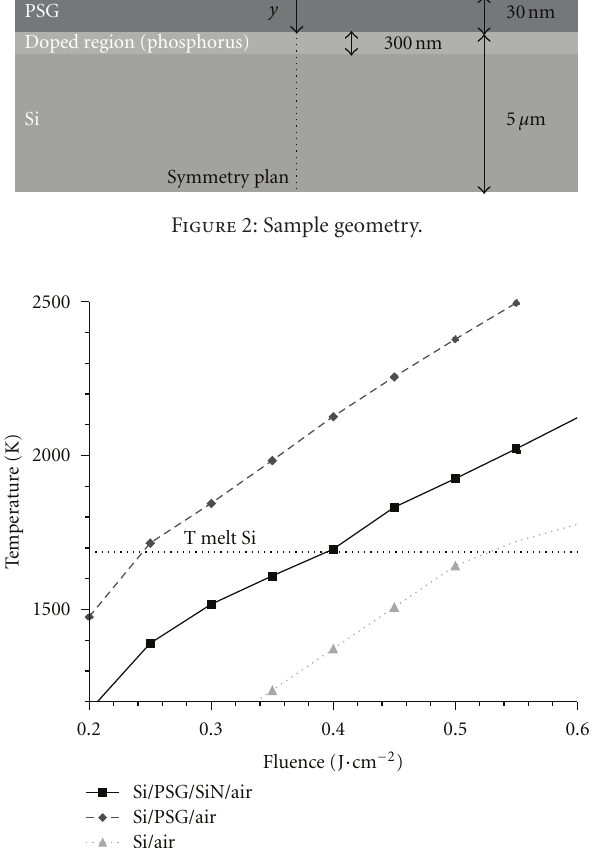
Figure 3: Simulated temperature versus laser fluence for di ff erent interfaces (Si/air, Si/PSG/air,